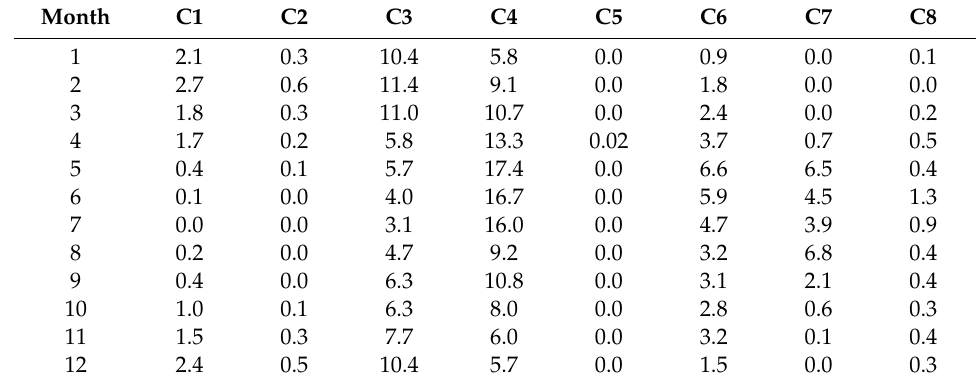
Table 3. Monthly source contributions to ambient PM 2.5 by cluster for Santiago, year 2004 ( µ g / m 3 ).